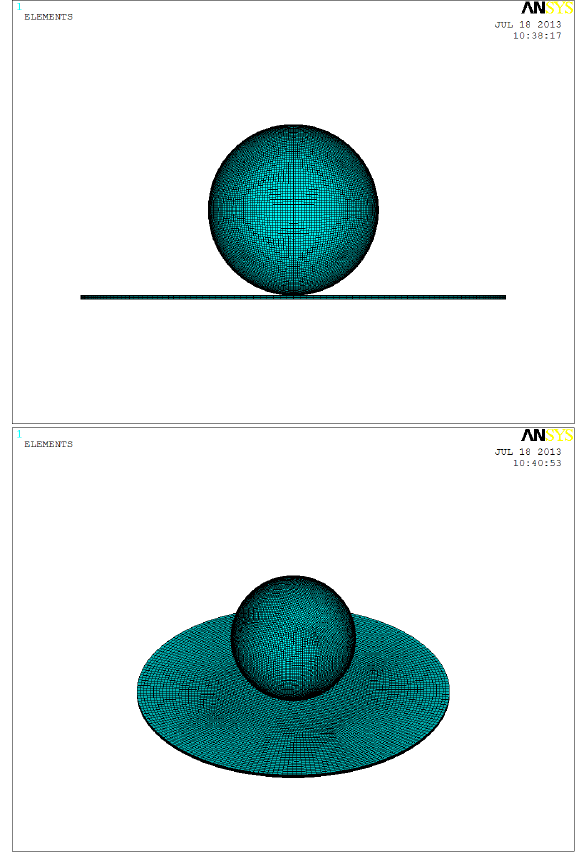
Figure 10. Finite element models.